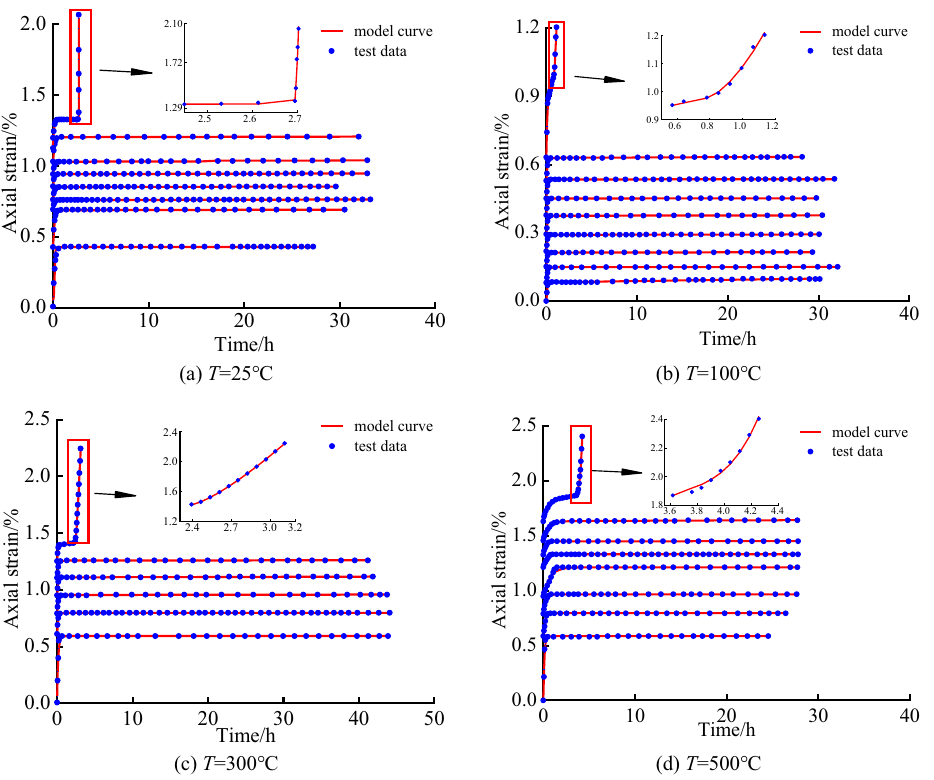
Figure 5. Comparative analysis of model curve and test data under different temperature conditions.